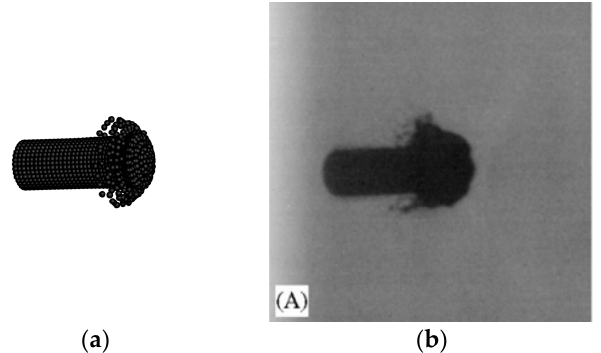
Figure 18. A comparison between the simulated mushrooming deformation of the projectile at 8 μ s and the corresponding experimental result: ( a ) SPH simulation; ( b ) Experiment result [30].